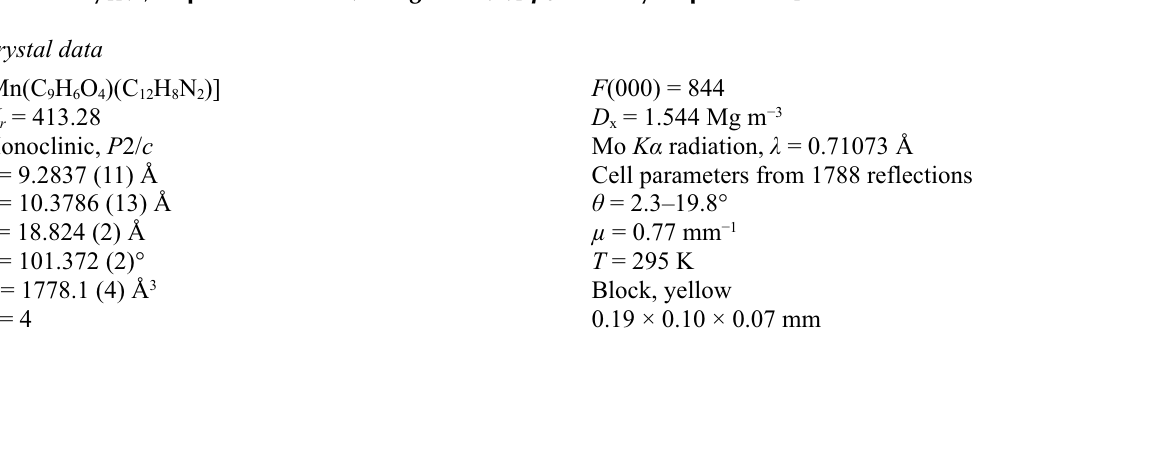
sup-2 Acta Cryst. (2008). E 64 , m1522